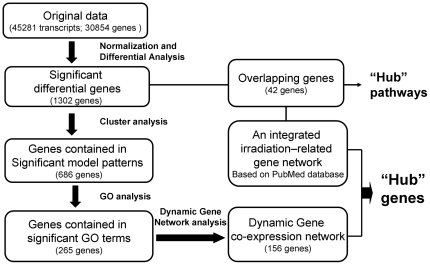
Flow chart of bioinformatics analyses for selecting hub genes and pathways related to IR.